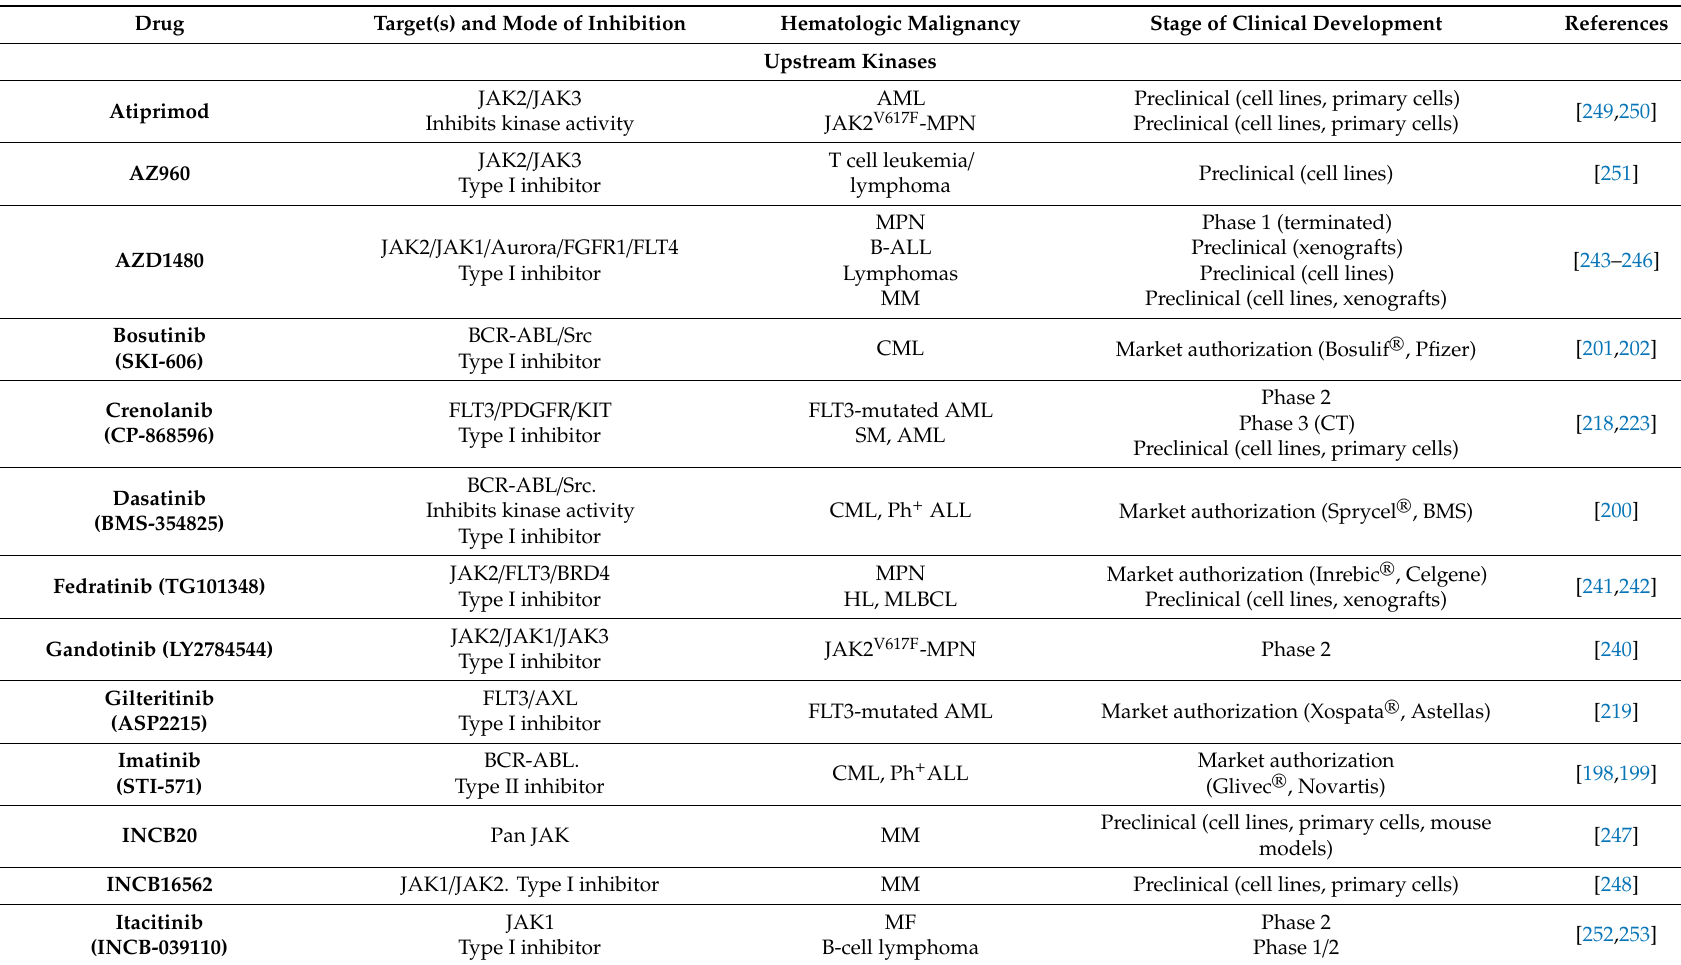
Table 2. Indirect inhibitors of STAT3 and STAT5 that have been tested in hematologic